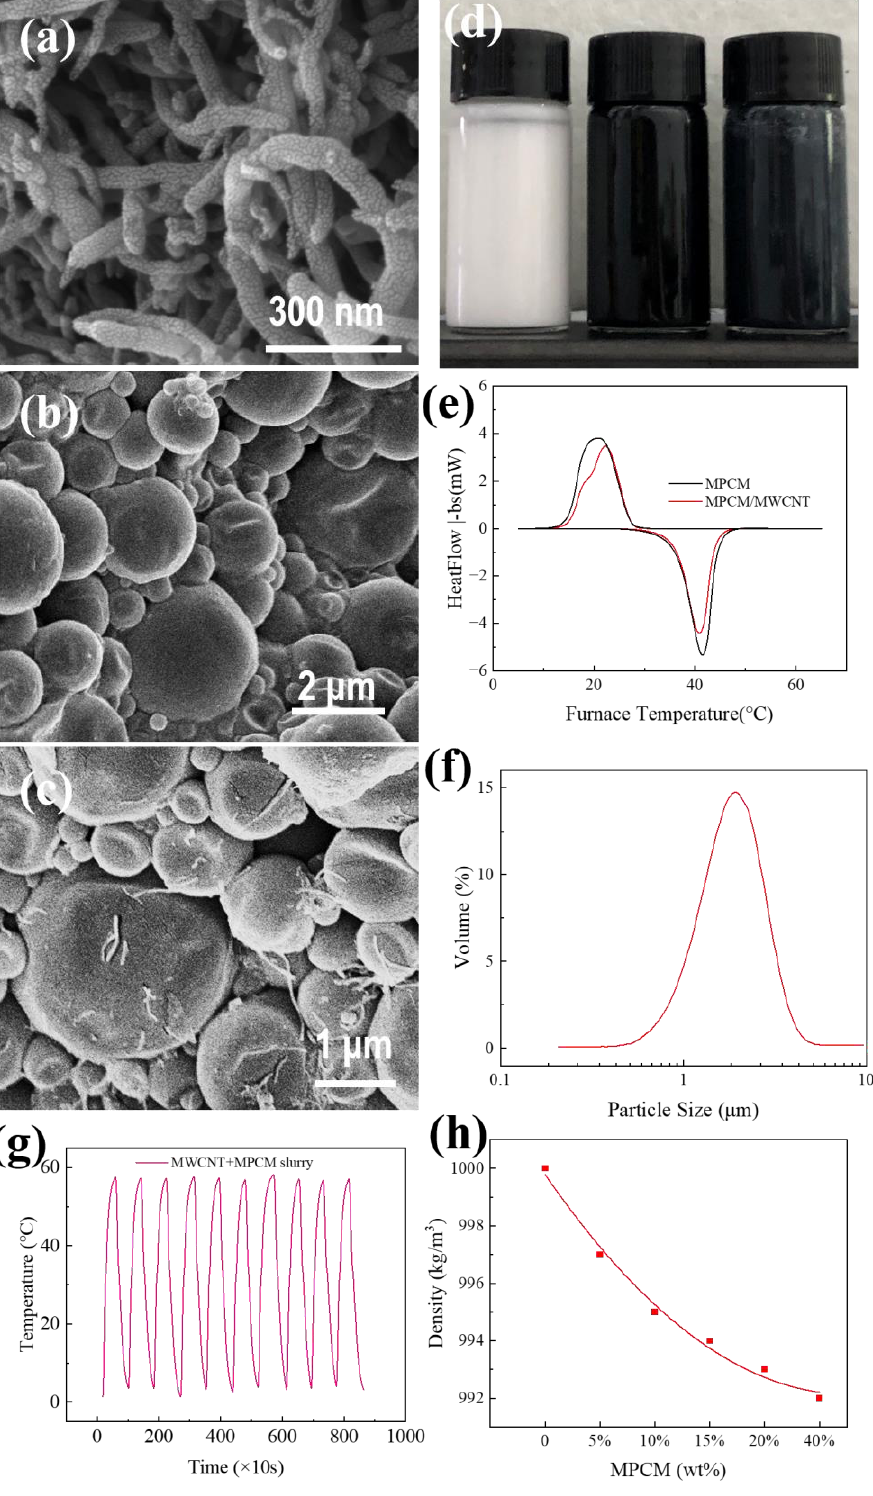
Figure 3. SEM: ( a ) MWCNT, ( b ) MPCM, and ( c ) MWCNT-MPCM; ( d ) digital images of MPCM slurry, MWCNT water dispersion, MWCNT-MPCM slurry (from left to right), ( e ) DSC curves, ( f ) particle size distribution of MPCM, ( g ) thermal cycle test, and ( h )